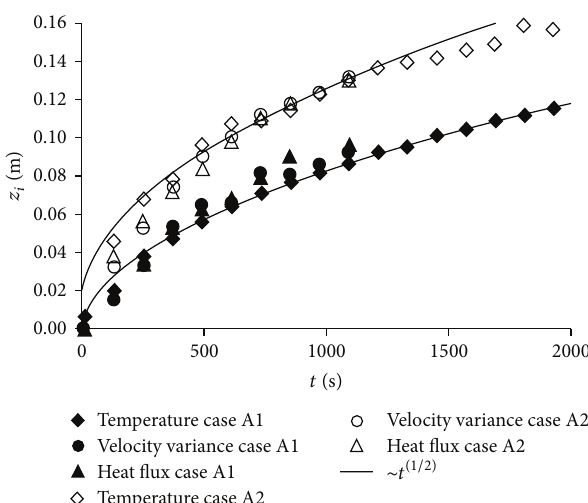
Figure 7: Comparison of CBL growth for experiments A1 and A2 detected with different methods: temperature measurements, velocity data, and relation (3).